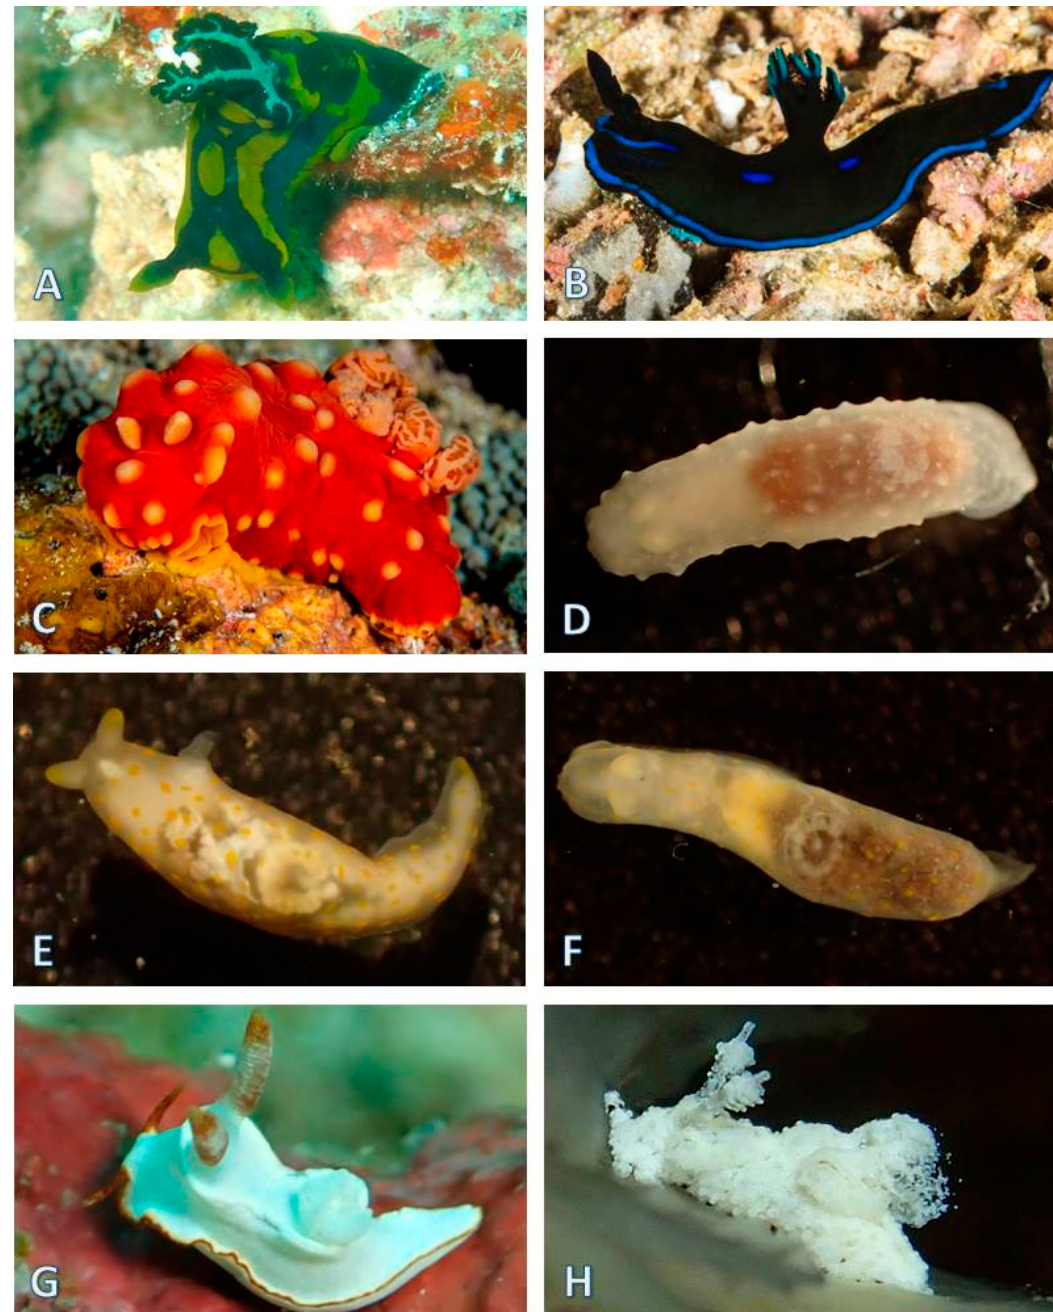
Figure 8. Nudibranchia Doridina: ( A ) Tambja gabrielae, Taga18Ba-1; ( B ) Tambja morosa*; ( C ) Gymnodoris aurita*; ( D ) Gymnodoris tuberculosa, Gytu18Ba-1; ( E ) Gymnodoris sp. ( Gymnodoris sp. 20 in Gosliner et al. [24]: 156), Gysp20-18Ba1 ; ( F ) Gymnodoris sp. ( Gymnodoris sp. 25 in Gosliner et al. [24]: 157), Gysp25-18Ba1; ( G ) Goniodoris sp. ( Goniodoris sp. 7 in Gosliner et al. [24]: 153), Gosp7-18Ba1; ( H ) Trapania armilla, Trar17Ba-1 . *Specimen not collected.